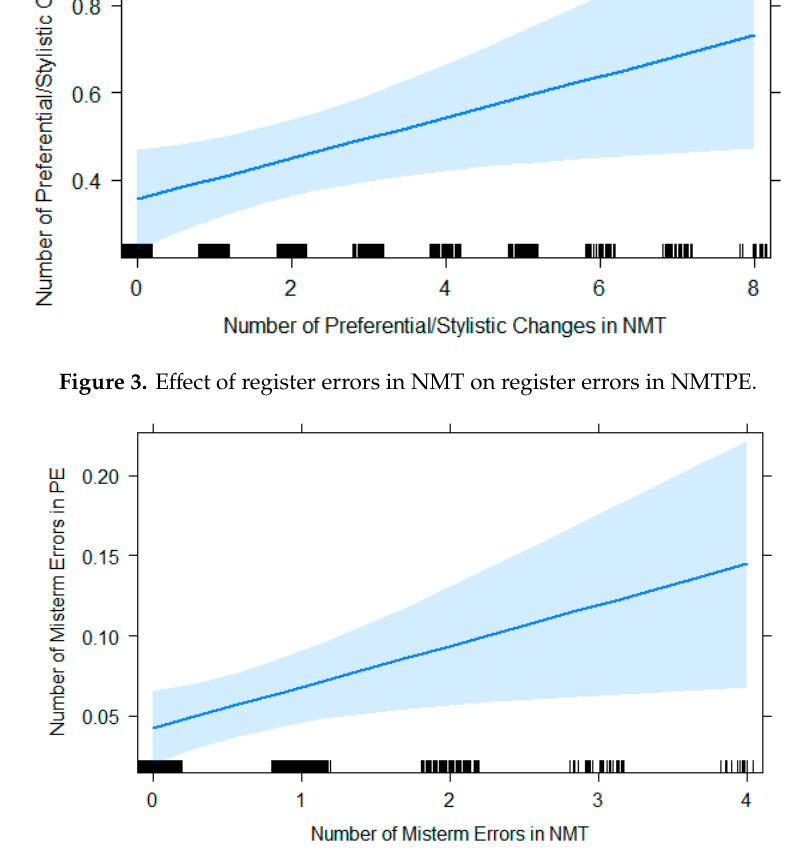
Figure 4. E ff ect of Misterm errors in NMT on NMTPE Misterm Figure 4. Effect of Misterm errors in NMT on NMTPE Misterm errors.